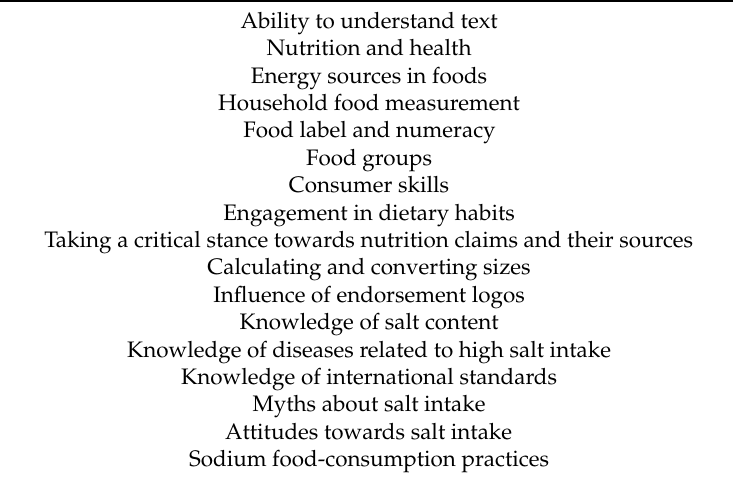
Table 1. Common food-literacy